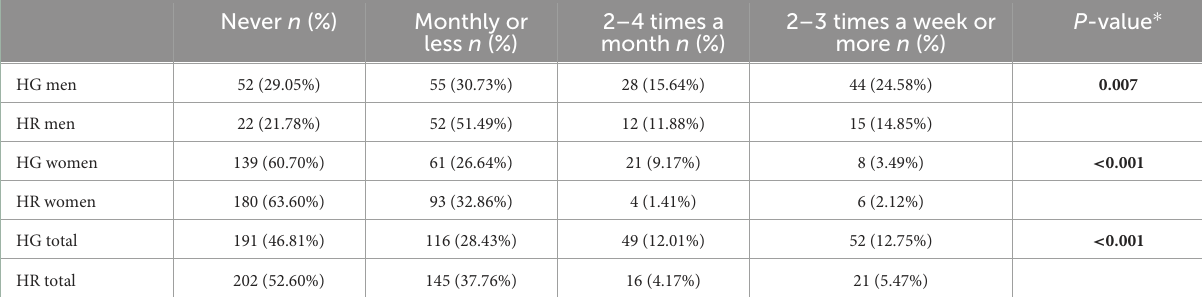
TABLE 2 Drinking frequency and prevalence (AUDIT question 1) among the Hungarian general and Roma populations, by